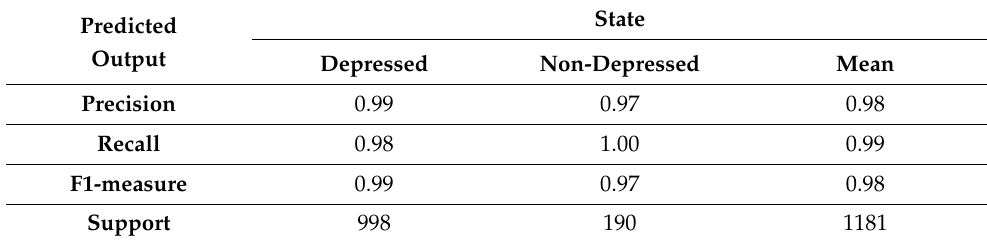
Table 3. Fold-10 Result of Proposed